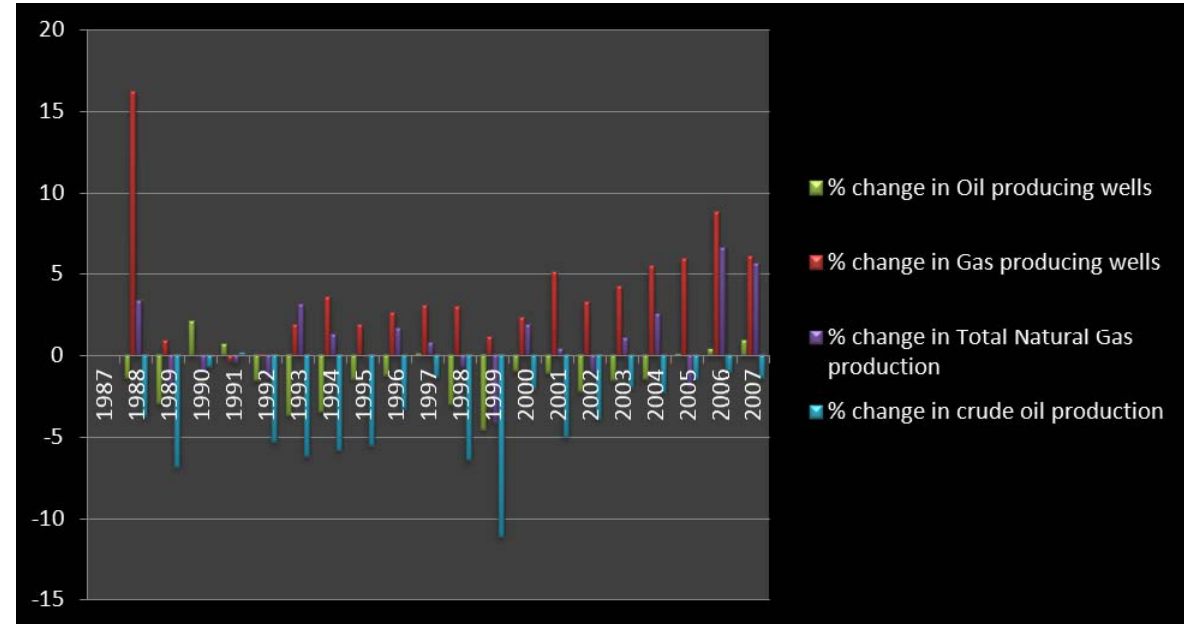
Figure 5. Graphical Summary of the Percentage of Change.